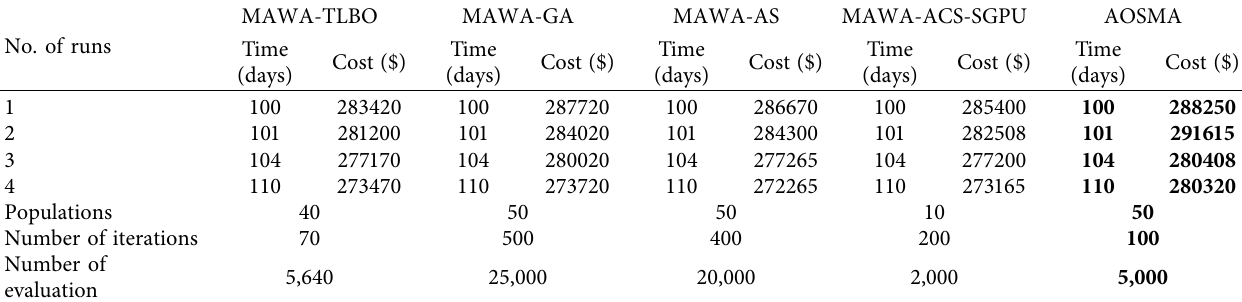
Table 10: Comparison of diferent algorithms and